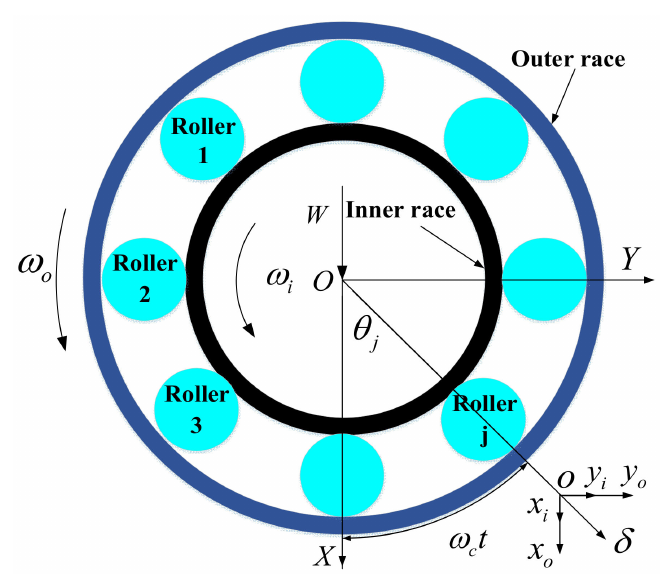
Figure 2. Simplified model of inter-shaft